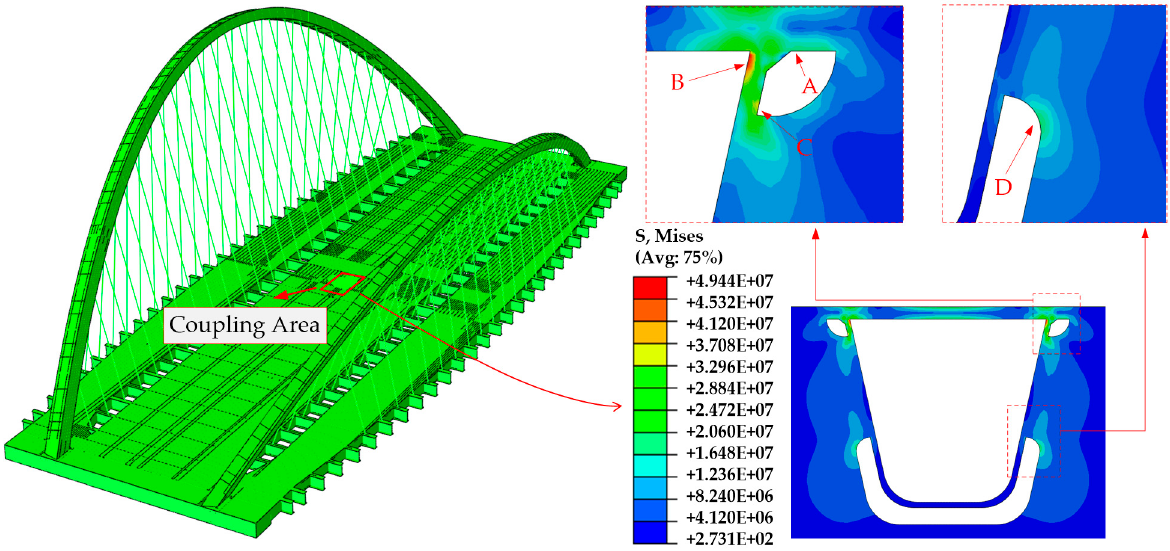
Figure 9. Numerical result of the Arlequin model (MC model). Table 2. Stress results of the global model and the local model (unit: MPa).